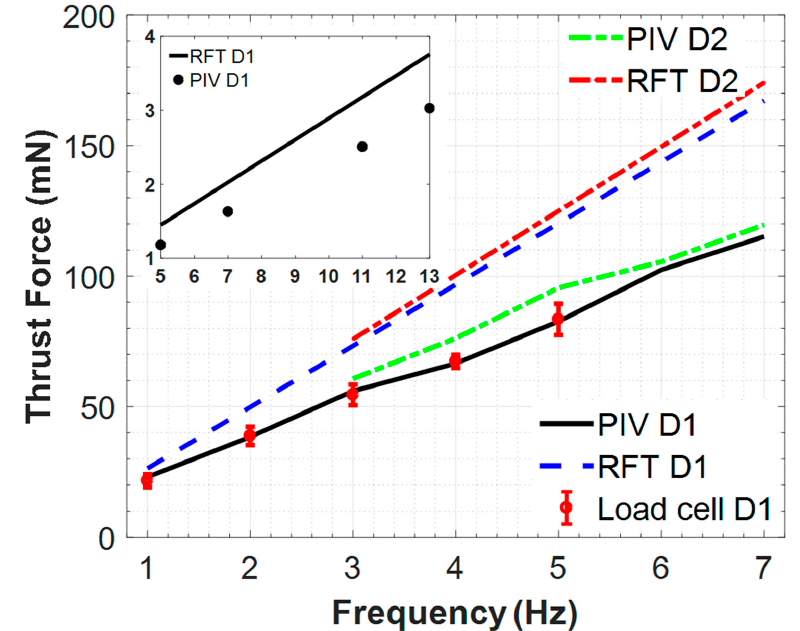
Figure 9. Thrust force comparisons chart: Big chart compares the thrust force for D1 (single) and D2 (overlapping) configurations rotating in 30,000 cSt silicone oil, and the inset chart depicts the thrust force for D1 configuration rotating in 350 cSt silicone oil with the same axes unit as the big chart. Thrust is computed and measured using PIV, load cell measurements and the RFT. Error bars correspond to simultaneous thrust measurements with 20 to 1 confidence level.